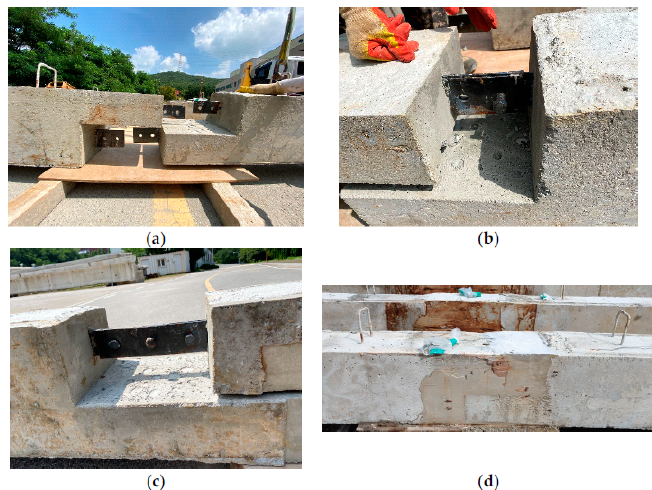
Figure 8. Construction process of proposed PC modular beam system: ( a ) PC modules; ( b ); assem- bling the steel plates; ( c ) connection with shear studs; ( d ) non-shrink mortar injection.